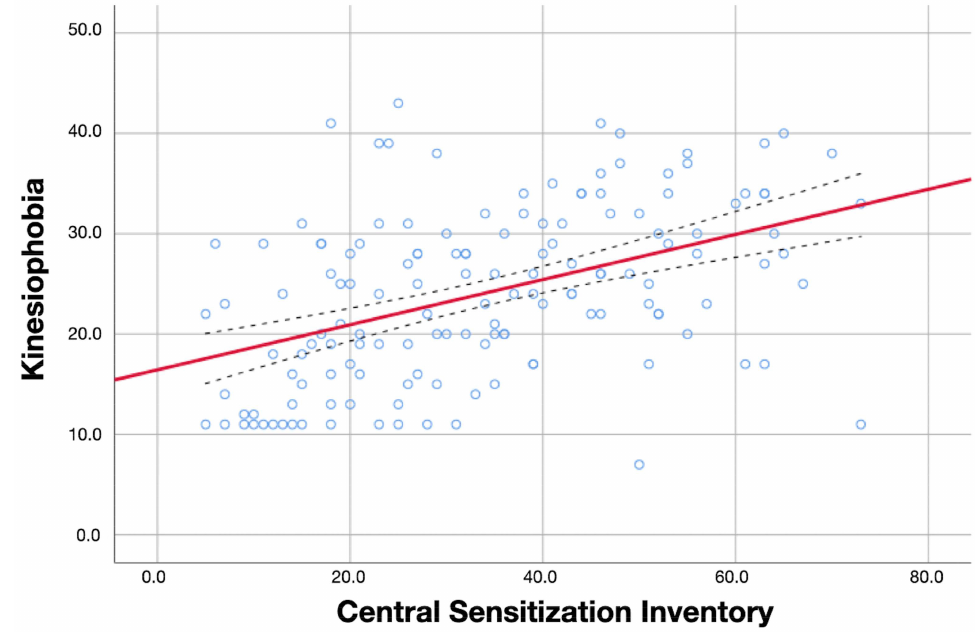
Figure 3. Association between kinesiophobia and sensitization-associated symptoms (CSI). Red line represents the correlation coefficient whereas blue dot lines represent the confidence intervals of the coefficient.